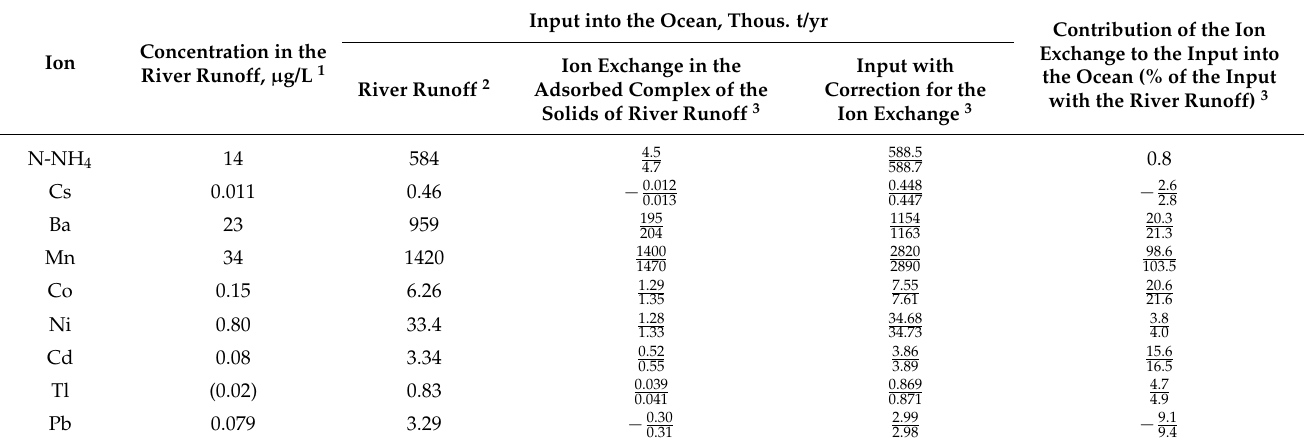
Table 5. Input of dissolved trace elements with river runoff into the ocean with correction for the ion exchange in the adsorbed complex of solid